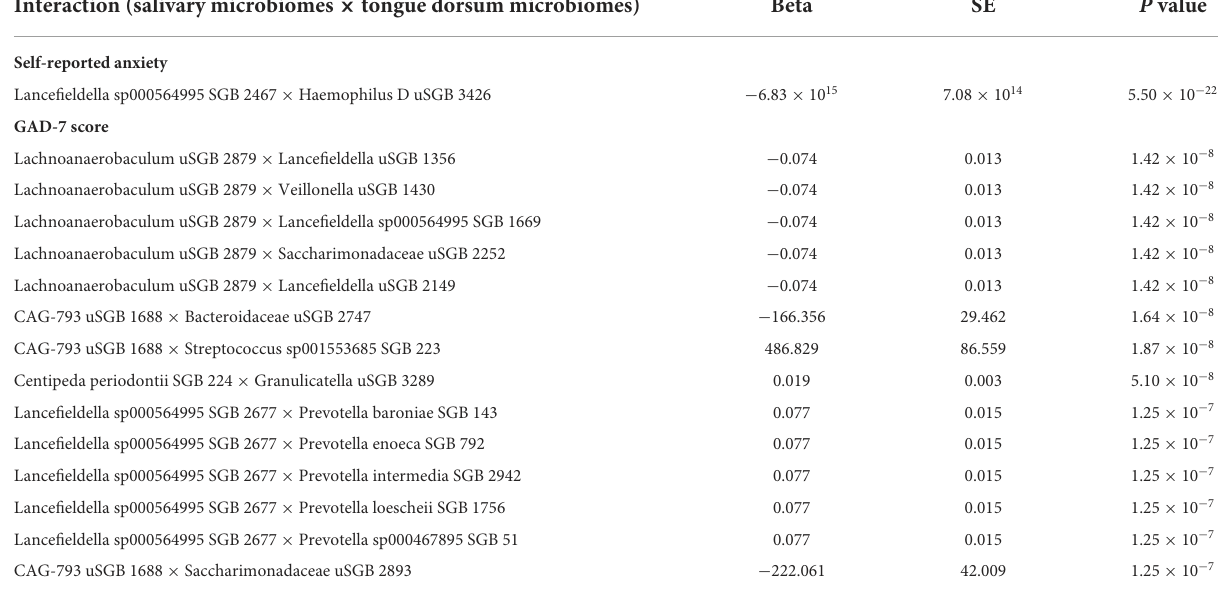
TABLE 3 The significant salivary-tongue dorsum microbiomes interactions for self-reported anxiety and GAD-7 score. Interaction (salivary microbiomes × tongue dorsum